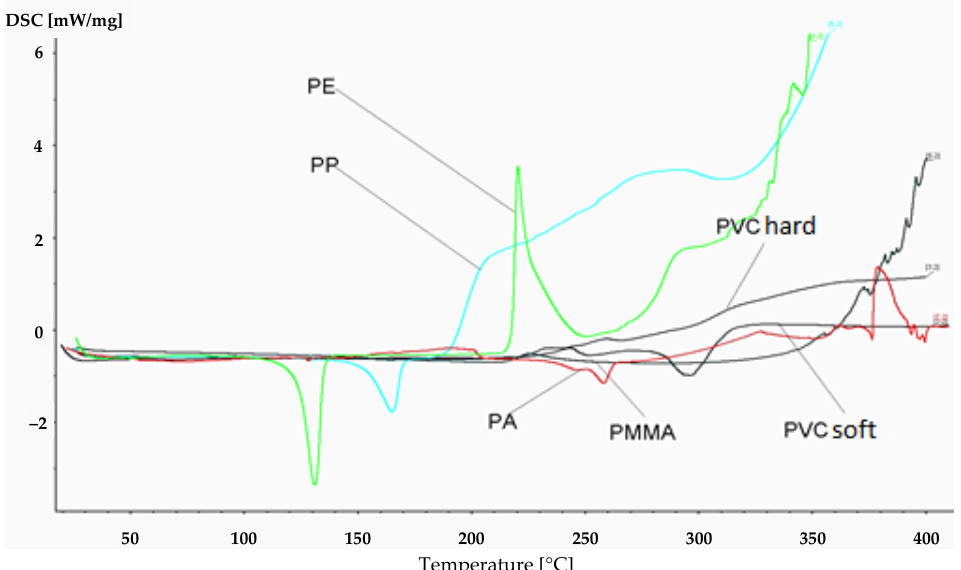
Figure 1. Differential scanning calorimeter (DSC) analysis of pure polymers used in the case study: polyvinyl chloride (PVC), including hard PVC (uPVC) and soft PVC (PVC-P); polyethylene (PE); polypropylene (PP) ; polyamide (PA); and poly(methyl methacrylate) (PMMA).